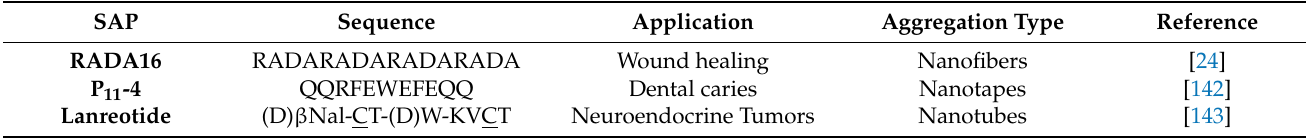
Table 1. Self-assembled peptides in the pharmaceutical